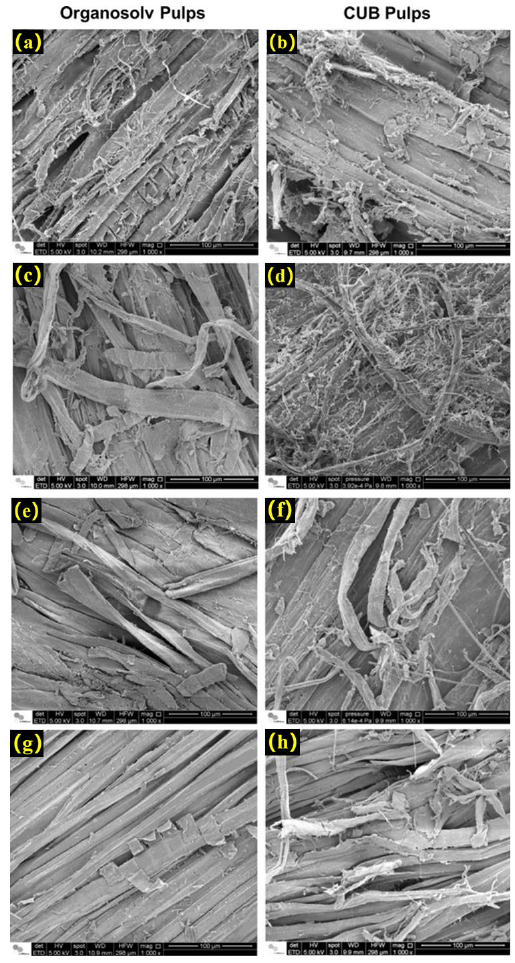
Figure 6. FESEM images of organosolv pulps and CUP pulps: ( a , b ) were obtained at 160, ( c , d ) at 180, ( e , f ) at 200, and ( g , h ) at 220 °C [36].